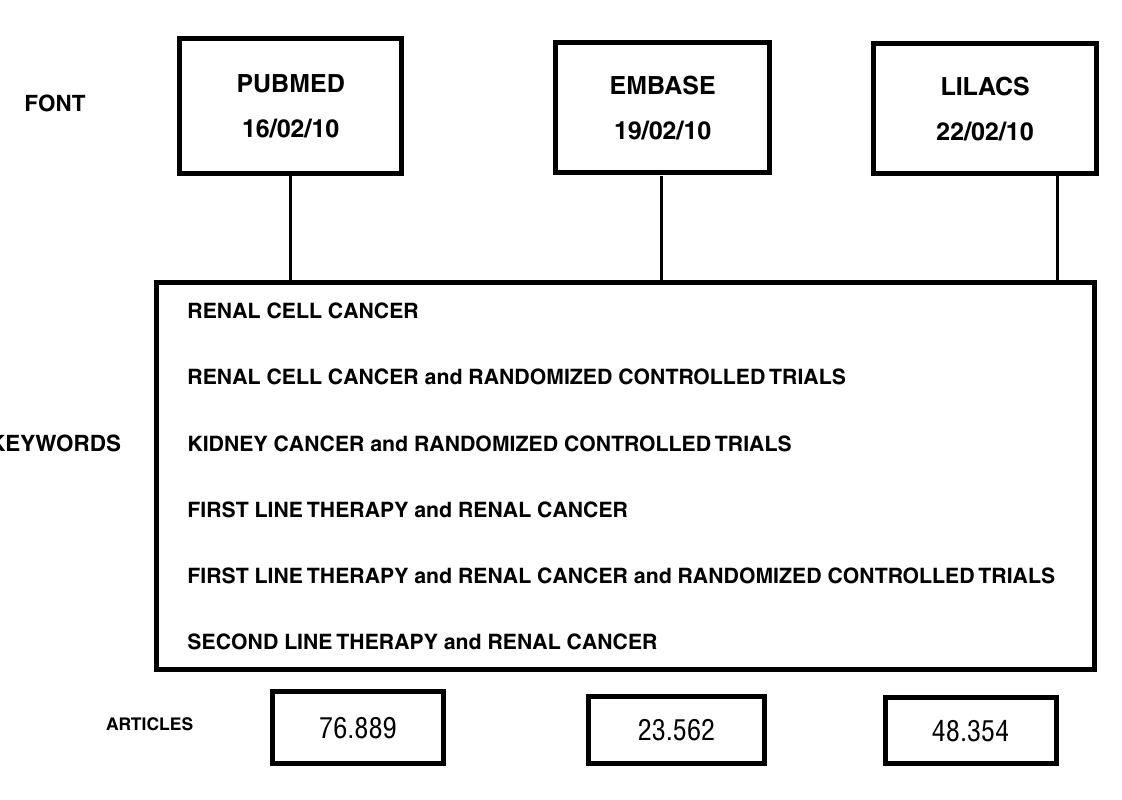
Figure 1 - Search result: systematic